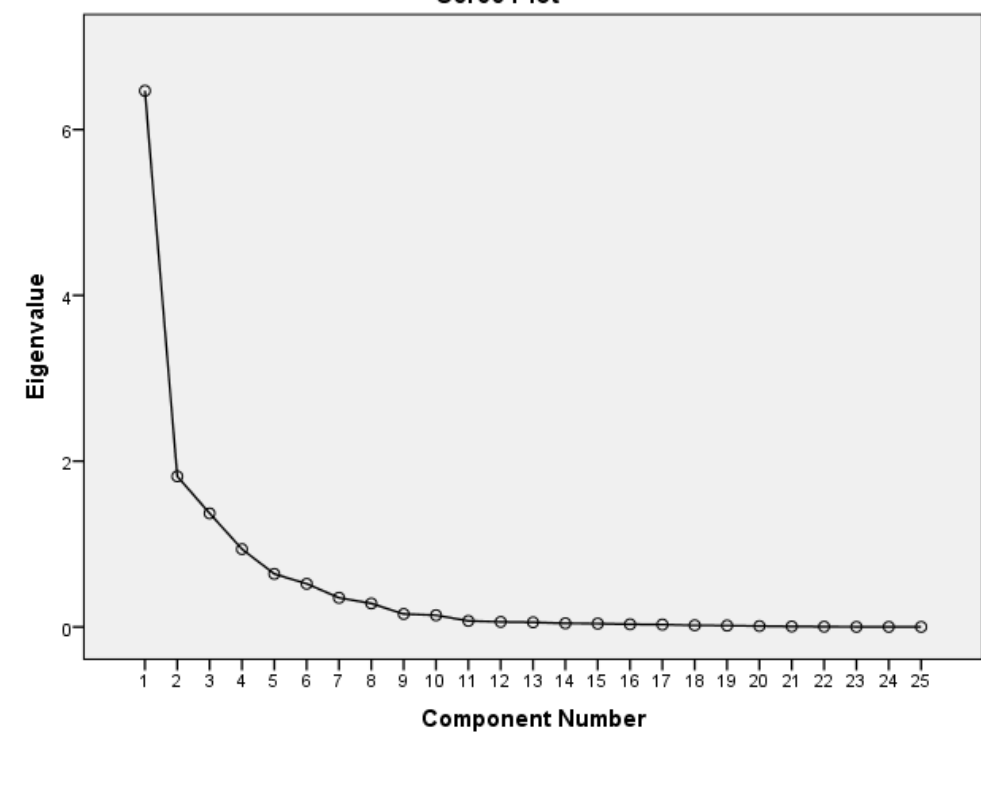
Figure 1. Scree plot of Eigen values after Principal Components Analysis.